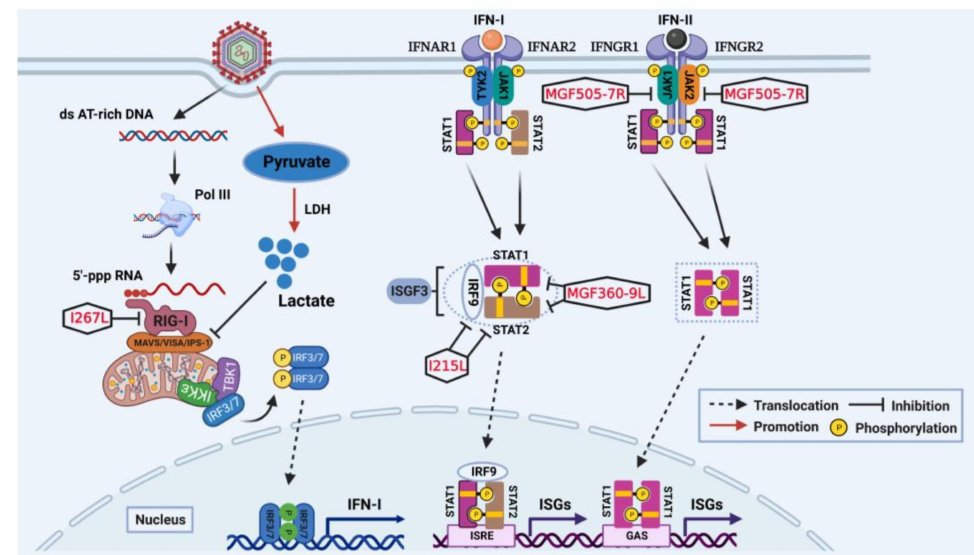
Figure 1. Schematic overview of impairment on IFN-I production targeting RIG-MAVS axis and IFN- induced antiviral responses by ASFV proteins in the latest reports. After ASFV infection, viral pI267L and increased lactate inhibit IFN-I production. Mechanistically, pI267L destroys the stabilized form of activated RIG-I and lactate to prevent the aggregation of MAVS. ASFV pI215L and pMGF360-9L inhibit IFN-I-induced antiviral response, while pMGF505-7R inhibit IFN-II-induced antiviral response. Mechanistically, pI267L mediates the degradation of IRF9 and STAT2, pMGF360-9L mediates the degradation of STAT1 and STAT2, and pMGF505-7R mediates the degradation of JAK1 and